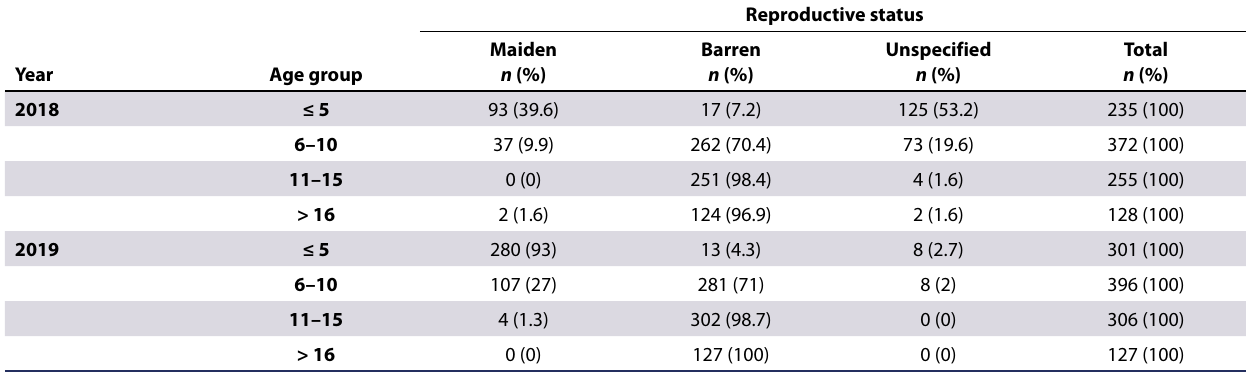
Table I: The number and percentage of Thoroughbred maiden, barren and unspecified mares, tested as part of the South African stud health scheme, comprising each age category in 2018 ( n = 990) and 2019 ( n = 1 130)